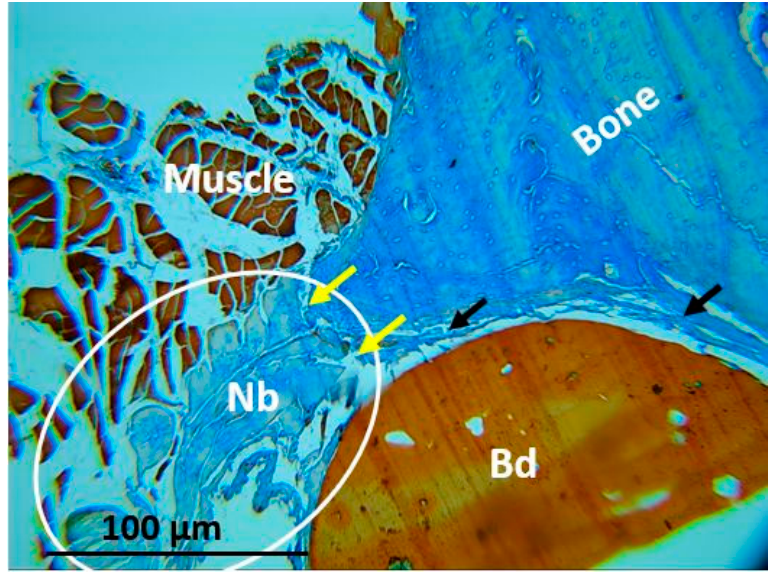
Figure 6. Implantation area for F5. White circle: Area of newly formed bone. NB: Newly formed bone. Yellow arrow: Interface between the newly formed bone and the surrounding bone. Bd: Bead.